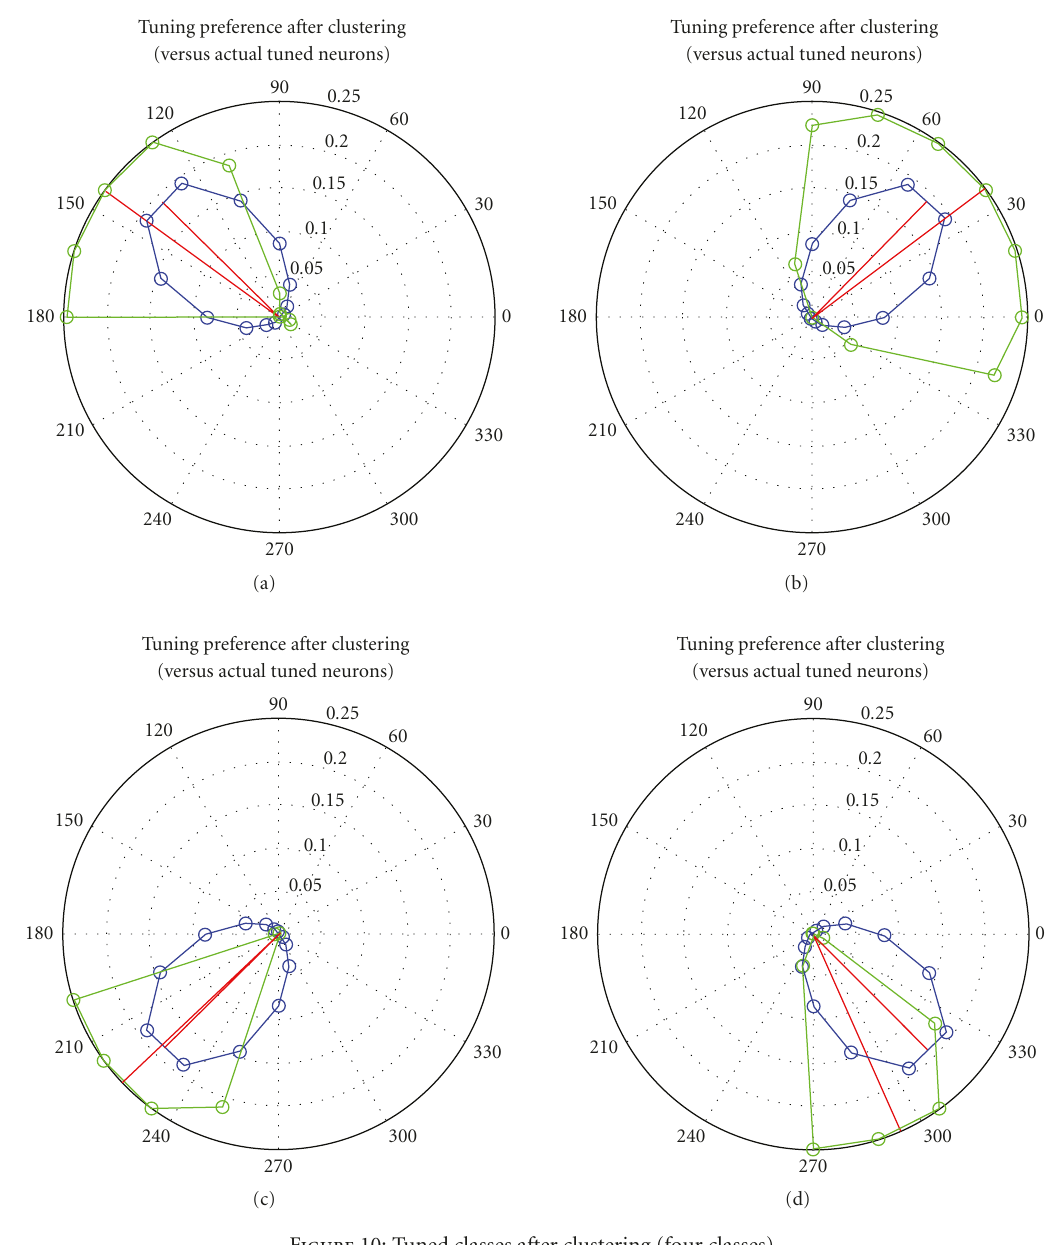
Figure 10: Tuned classes after clustering (four